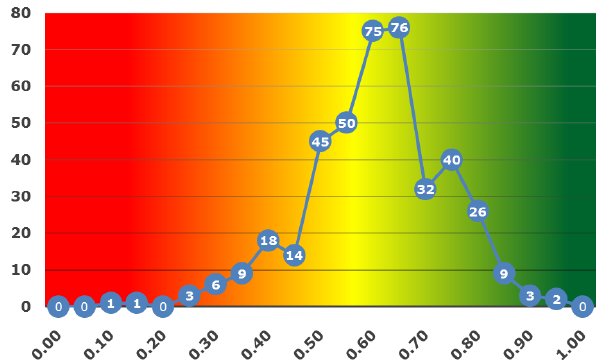
Figure 4. Distribution of OSSI values for all open spaces.